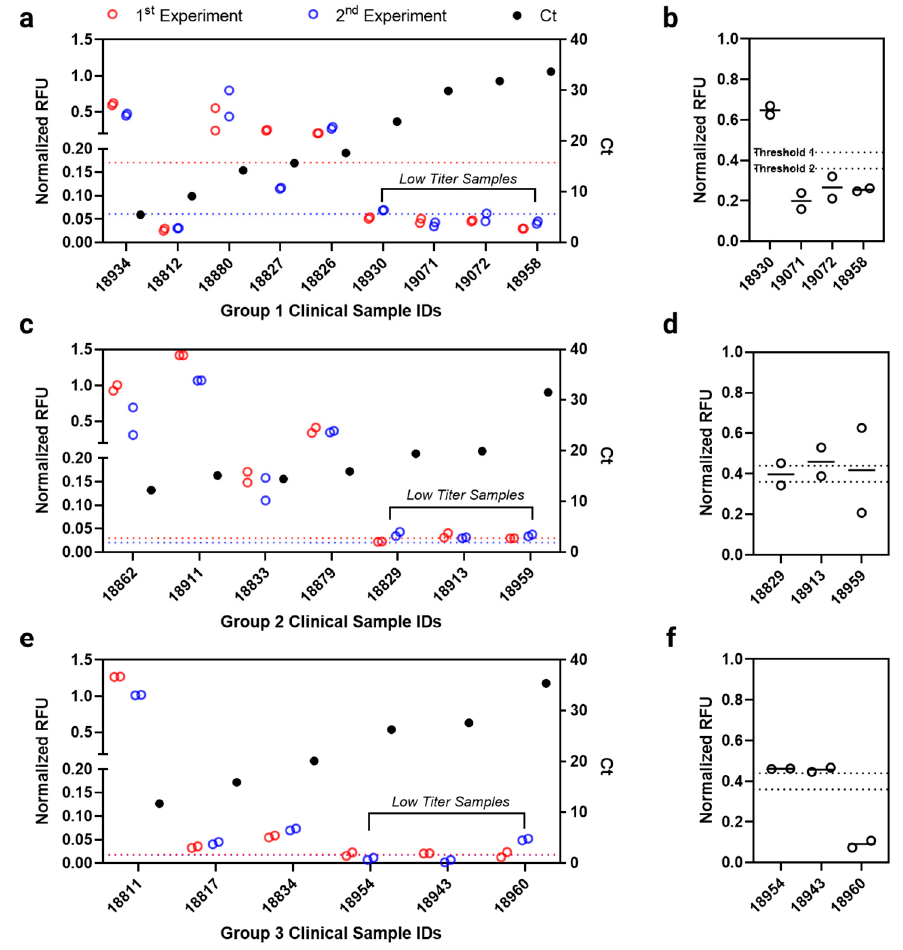
Figure 4. Clinical sample testing on the protein microarray. A total of 22 SARS-CoV-2 clinical samples was tested on the protein microarrays. These clinically diagnosed positive samples were previously tested by one of three FDA-authorized RT-PCR kit combinations: ( a ) Group 1 Alinity m SARS-CoV-2 assay or Abbott RealTime SARS-CoV-2 assay, ( c ) Group 2 Simplexa COVID-19 Direct assay or ABI 7500 Fast Dx SARS-CoV-2 assay test on the Thermo Fisher Applied Biosystems, ( e ) Group 3 Xpert Xpress SARS-CoV-2 test or Xpert Xpress CoV-2/Flu/RSV plus. Fluorescence signals were developed by following the scheme represented in the Figure 1c. Two independent experiments (a total of four technical replicates) were performed per sample for each group. Each clinical sample’s individual normalized RFU value is reported. The cycle threshold (Ct) value of each clinical sample is also reported on the right Y-axis. The threshold was calculated by adding average of the normalized RFU value of the negatively diagnosed clinical sample ( n = 8 technical replicates) to its 3X standard deviation from all experiments. These thresholds were indicated by dotted lines on each graph. The samples below (or almost near) the threshold were designated as the “low titer samples”. ( b , d , f ) The low titer samples were re-tested with tyramide signal amplification (TSA), following the detection scheme represented in the Figure 1d. A single experiment with two technical replicates were performed where each clinical sample’s individual normalized RFU values are reported in hollow circles and their mean values as horizontal lines. The thresholds were calculated in the same manner where the Threshold 1 and 2 used 3X and 2X standard deviation of the negatively diagnosed clinical samples, respectively.